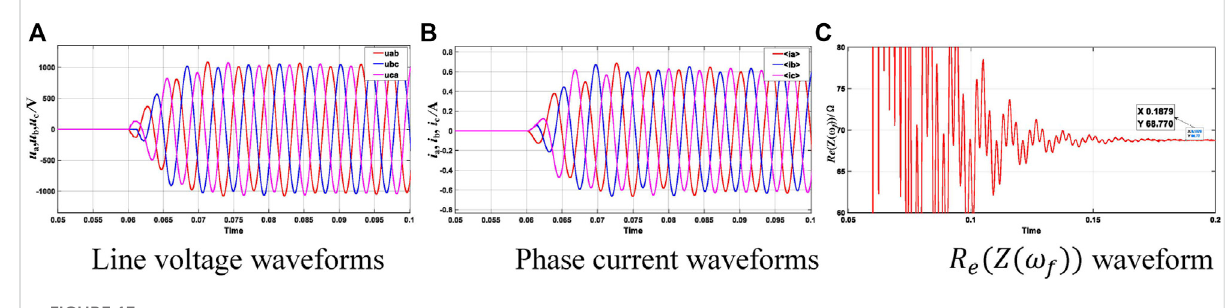
FIGURE 13 Instantaneous short circuit fault at end of